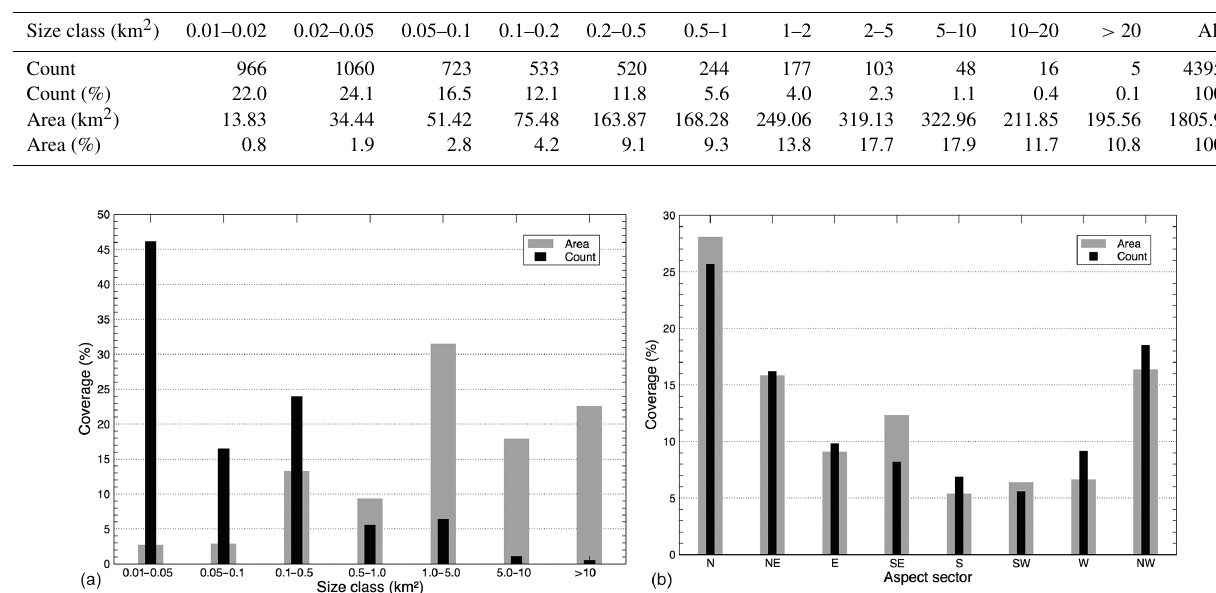
Figure 5. Relative frequency histograms for glacier count and area per (a) size class and (b) aspect sector for all glaciers.